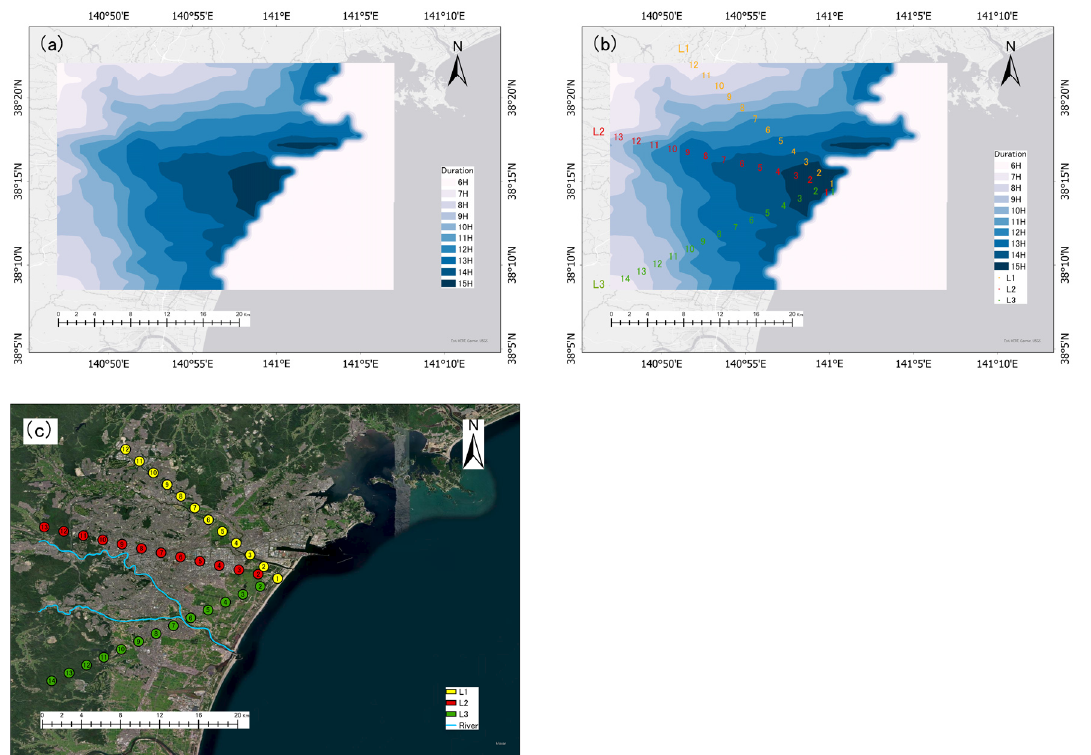
Figure 14. ( a ) Sea breeze duration time map; ( b ) distribution of points in the L1, L2 and L3 directions on the sea breeze duration time map; ( c ) distribution of points in the L1, L2 and L3 directions on the satellite map.